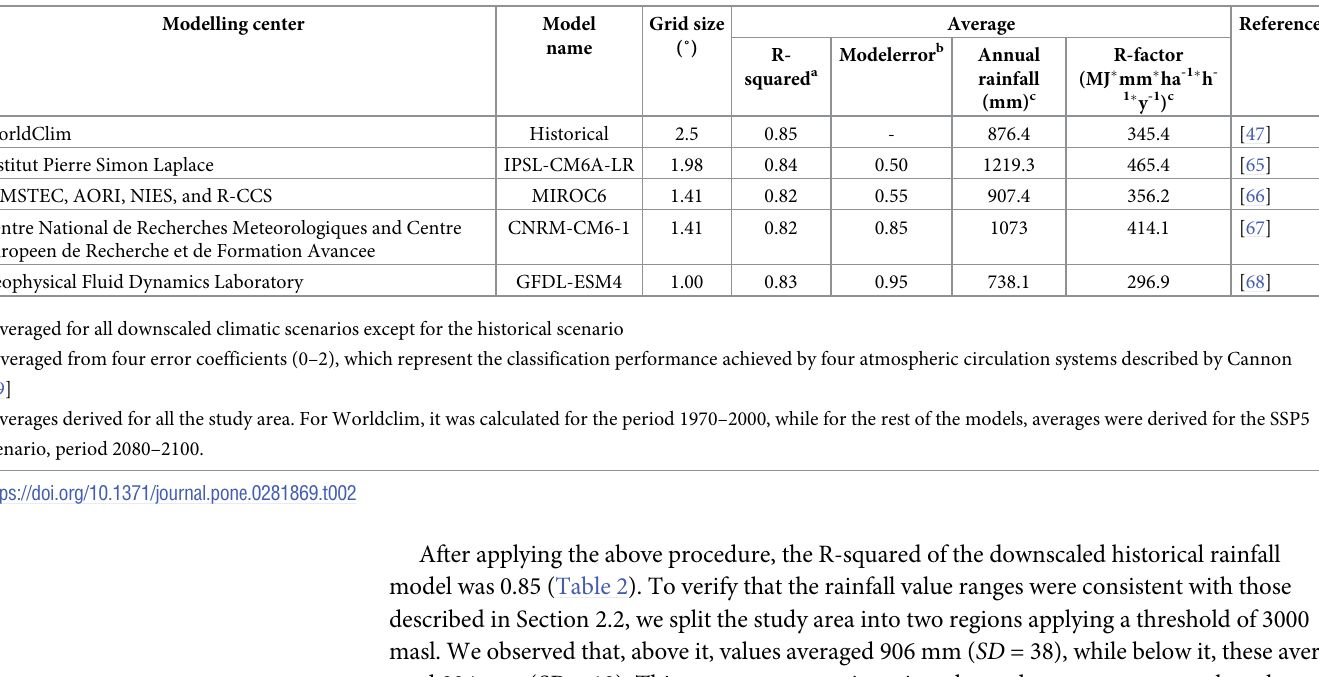
Table 2. Climate change scenarios used in this study, sorted by performance scores for South America according Cannon [59]. Modelling center